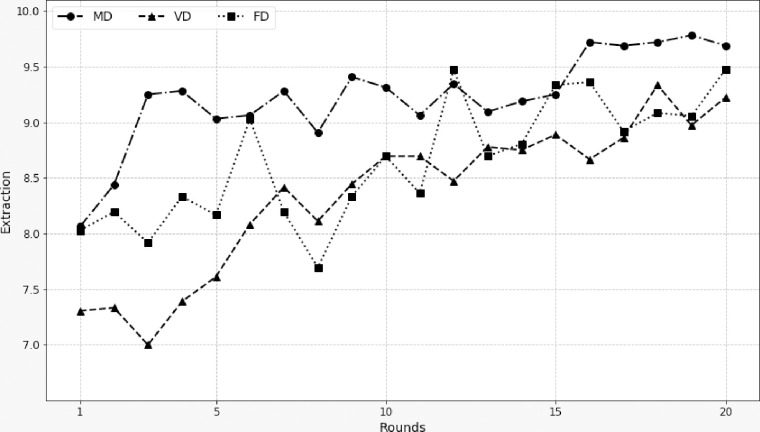
Evolution of average extraction per treatment.